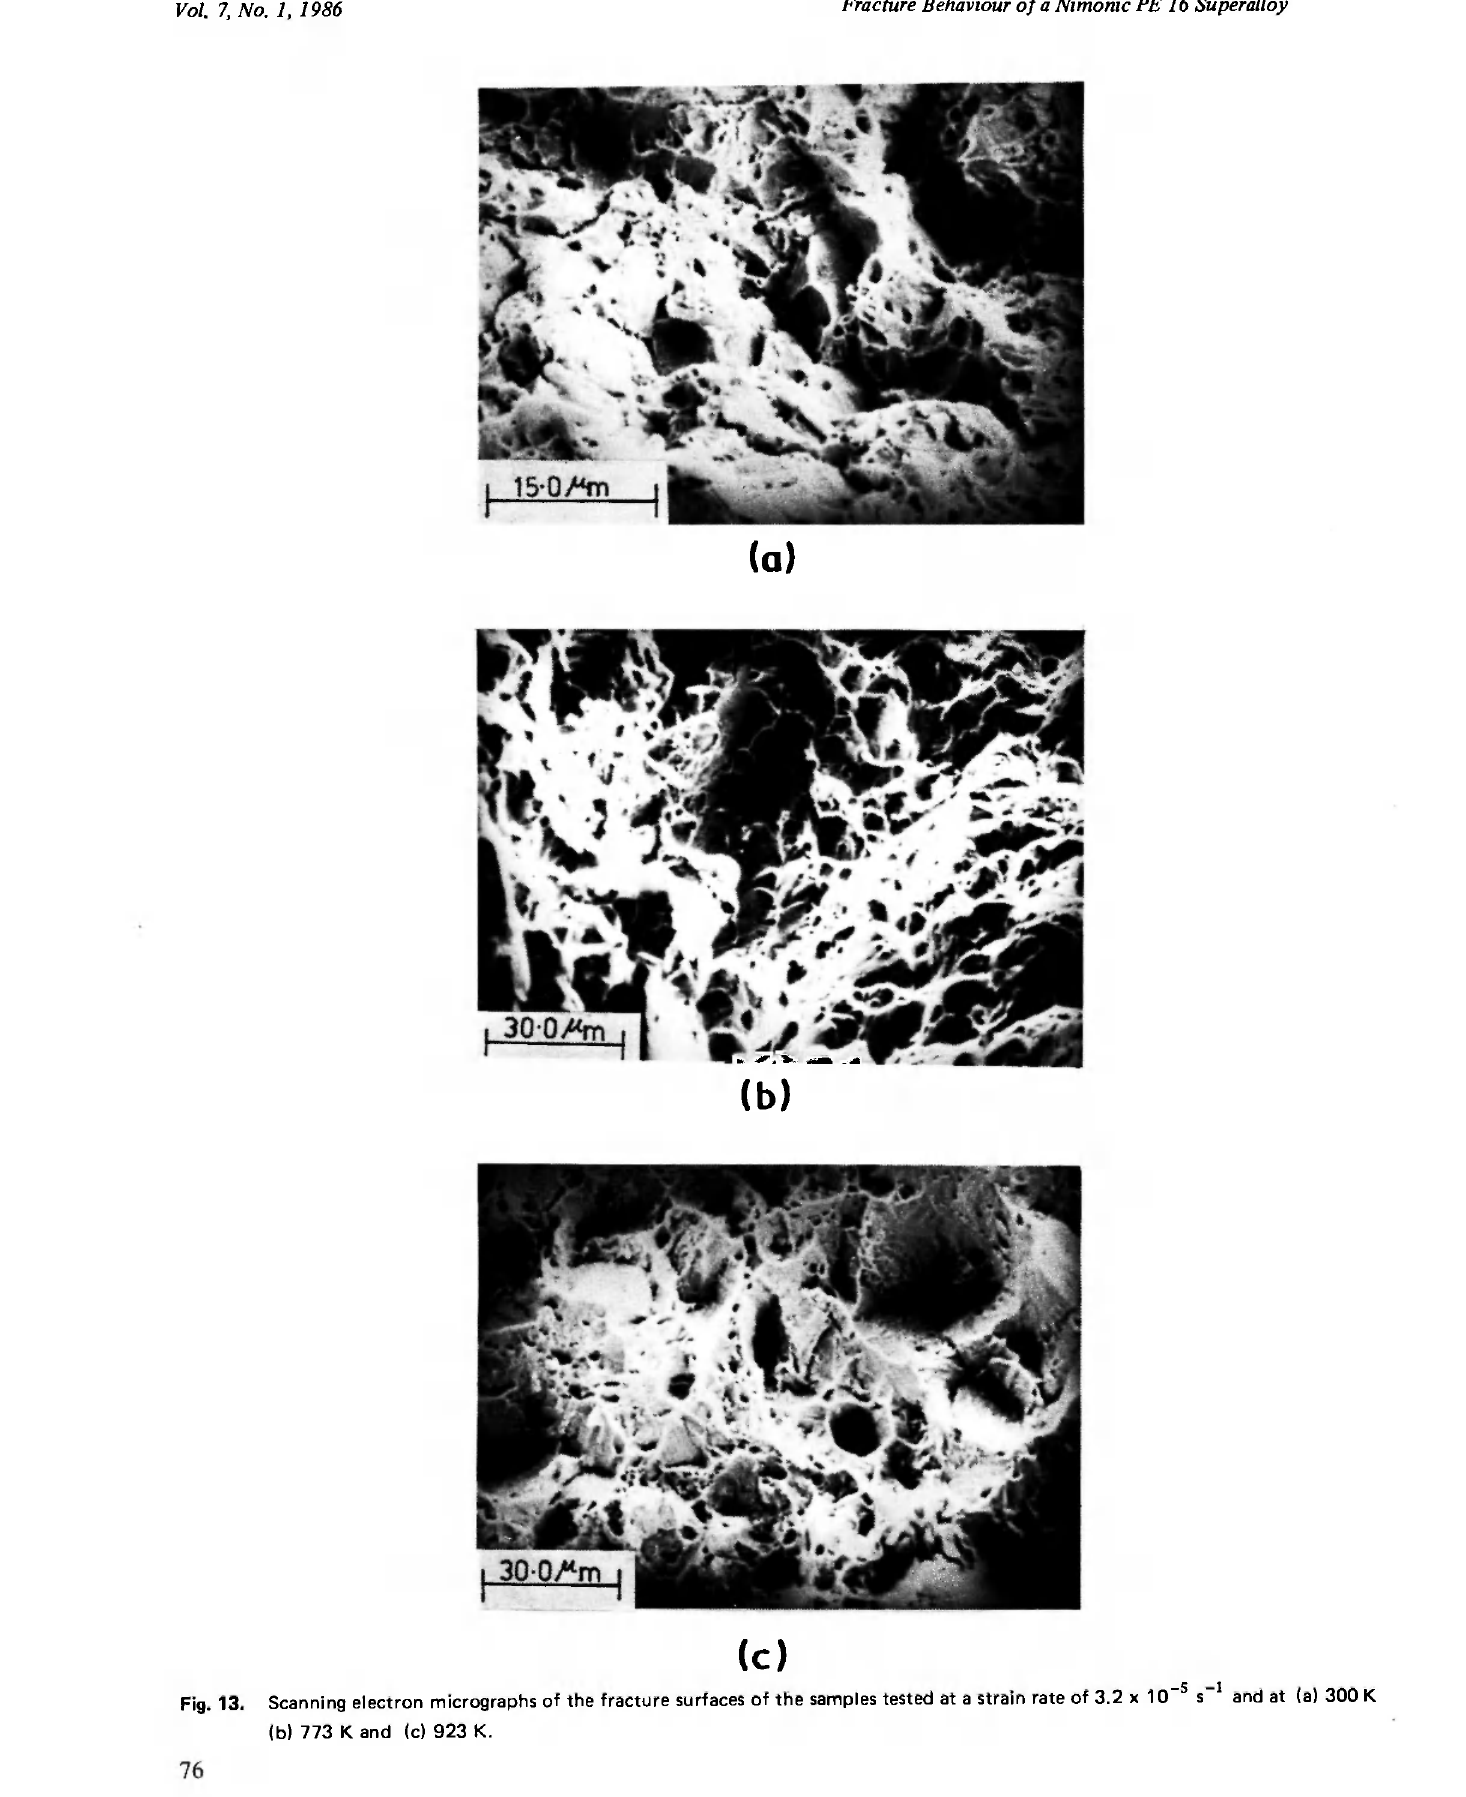
Fig. 13. Scanning electron micrographs of the fracture surfaces of the samples tested at a strain rate of 3.2 χ 10 5 s 1 and at (a) 300 Κ (b) 773 Κ and (c) 923